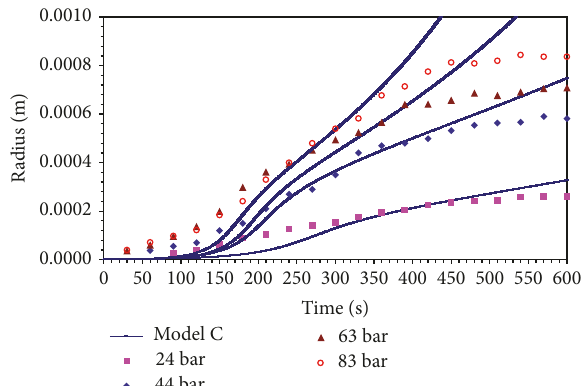
Figure 20: Model C versus experimental data for bubble growth at 100 ∘ C.